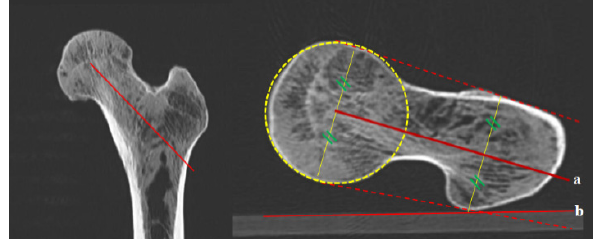
Figure 7. Femoral anteversion angle between a and b, using the C line on the axial oblique section. On the coronal section, the oblique plane that connects the center of the head and the mid-portion of the basal neck extends to the piriformis fossa. On the axial oblique section, (a) the middle solid line between the two dotted lines connects the anterior and posterior borders of the femoral head and the greater trochanter; (b) the connecting line of the posterior border of both femoral condyles.